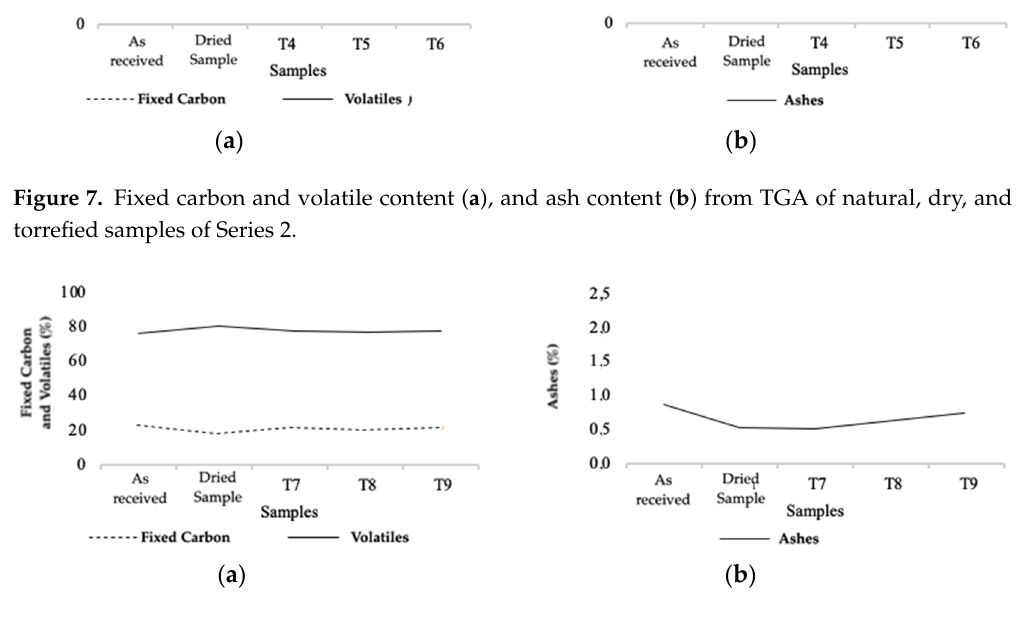
Figure 8. Fixed carbon and volatile content ( a ), and ash content ( b ) from TGA of natural, dry, and torrefied samples of Series 3.